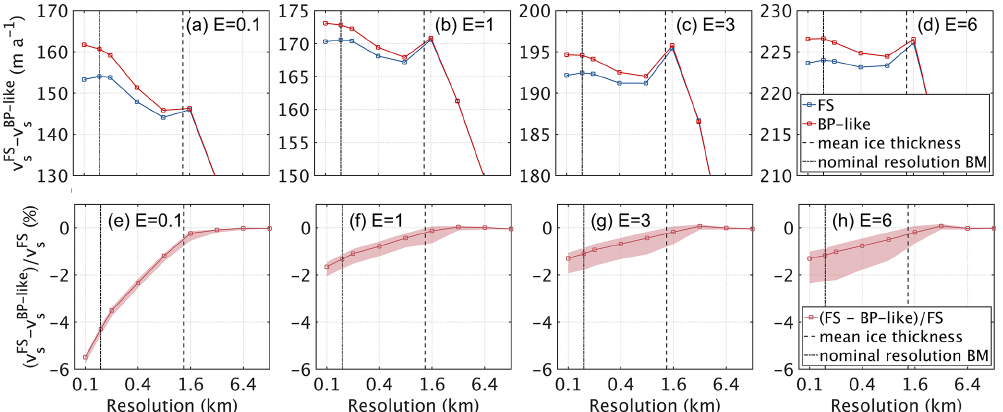
Figure 5. Integrative overview of spatially averaged surface velocities from FS and BP-like stress regimes. The upper row (a–d) shows surface velocity mean for E = 0 . 1, 1, 3 and 6, respectively. The lower row (e–h) shows the relative difference of BP-like to FS for E = 0 . 1, 1, 3 and 6, respectively. The lighter background indicates the local maximum and minimum relative differences. Please note the logarithmic scale of the x axis and the different scale of the y axis in the upper row.